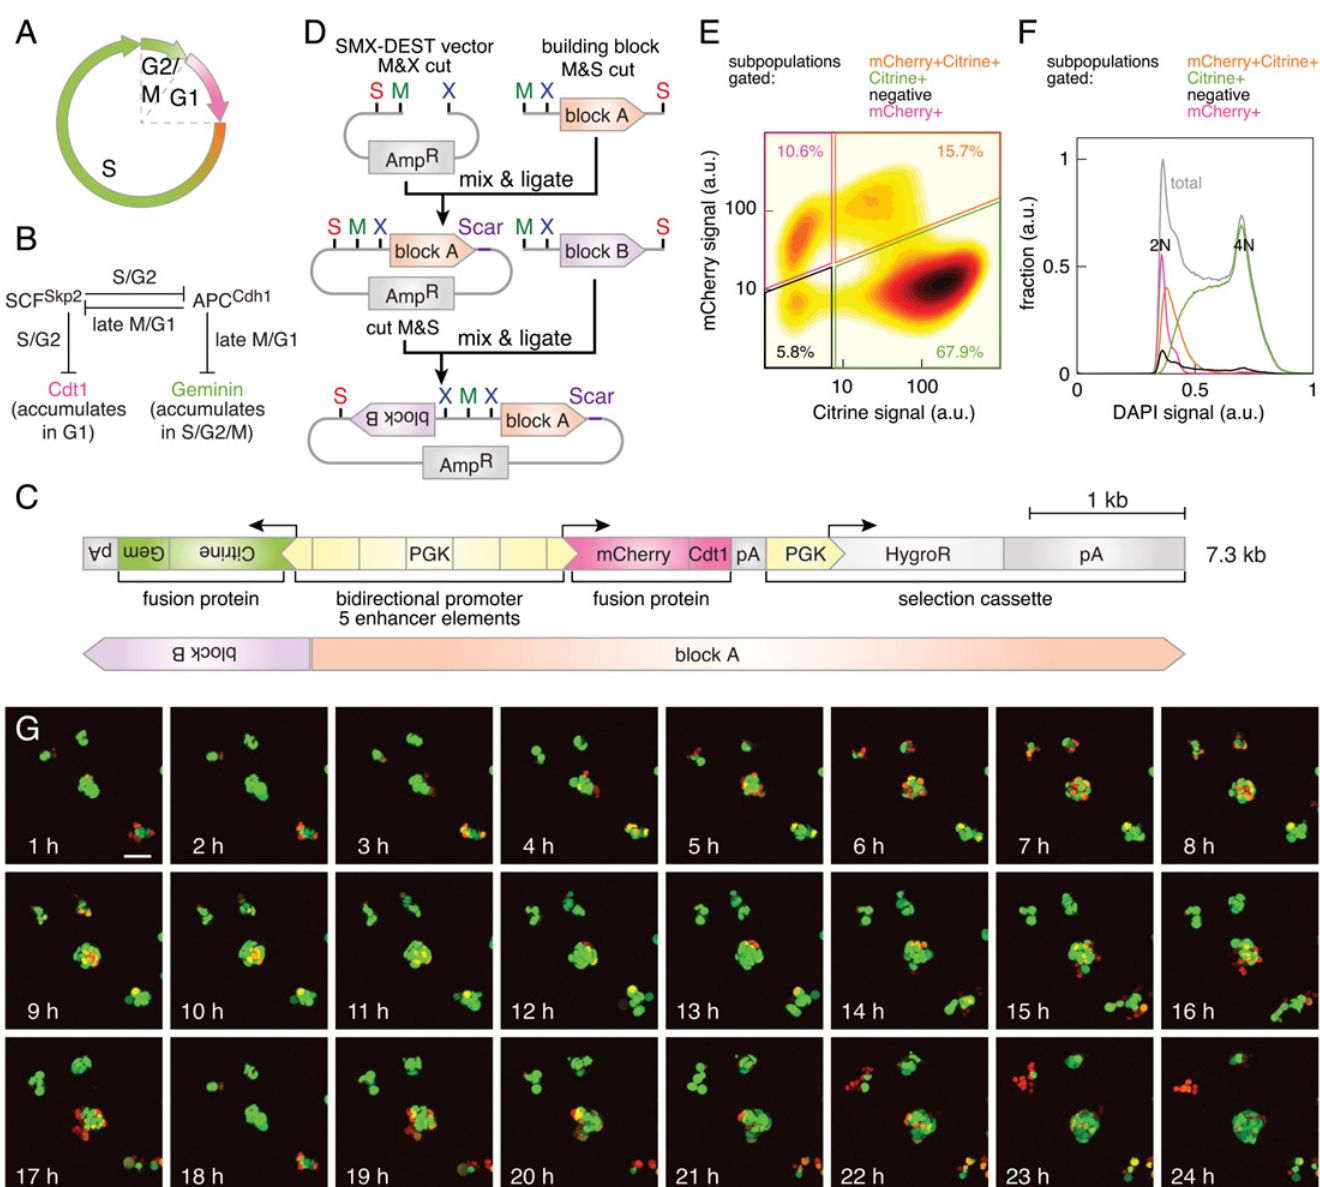
Fig 4. Adapting the FUCCI system to mouse embryonic stem cells. (A) FUCCI labels cells in G1 phase red, cells at the transition to S phase orange and cells in late S, G2 and M phases in green. (B) Molecular mechanism behind FUCCI. A double-negative feedback loop between the SCF Skp2 and APC Cdh1 complexes exhibits bistability and leads to the oscillating accumulation of their substrates Cdt1 in G1 phase and Geminin in late S, G2 and M phases (adapted from [5]). (C) Scheme of the FUCCI-based construct to monitor cell cycle progression in mESCs. Top: A bidirectional PGK-promoter containing five enhancer elements drives the expression of Citrine-Gem(aa 1 – 110) and mCherry-hCdt1(aa 30 – 120). Small gray boxes are bGHpAs, large gray boxes β - GpAs. Scale bar: 1 kb. Bottom: Orange and purple boxes indicate the identity of the building blocks, which were assembled head-to-head into the SMX_DEST vector, see as well (D). (D) Scheme of the cloning strategy using the SMX_DEST vector to arrange building blocks head-to-head. (E) Flow cytometry analysis of mCherry and Citrine fluorescence in a clonal transgenic mESC line stably expressing the construct shown in (C). The percentage of cells in each gate is shown. (F) Analysis of the cellular DNA content. DAPI signal distribution of each subpopulation outlined in (E) and of the total culture is shown. (G) Live imaging of a clonal transgenic culture expressing the construct shown in (C). Maximum intensity projections of confocal sections are displayed. Scale bar: 50 μ